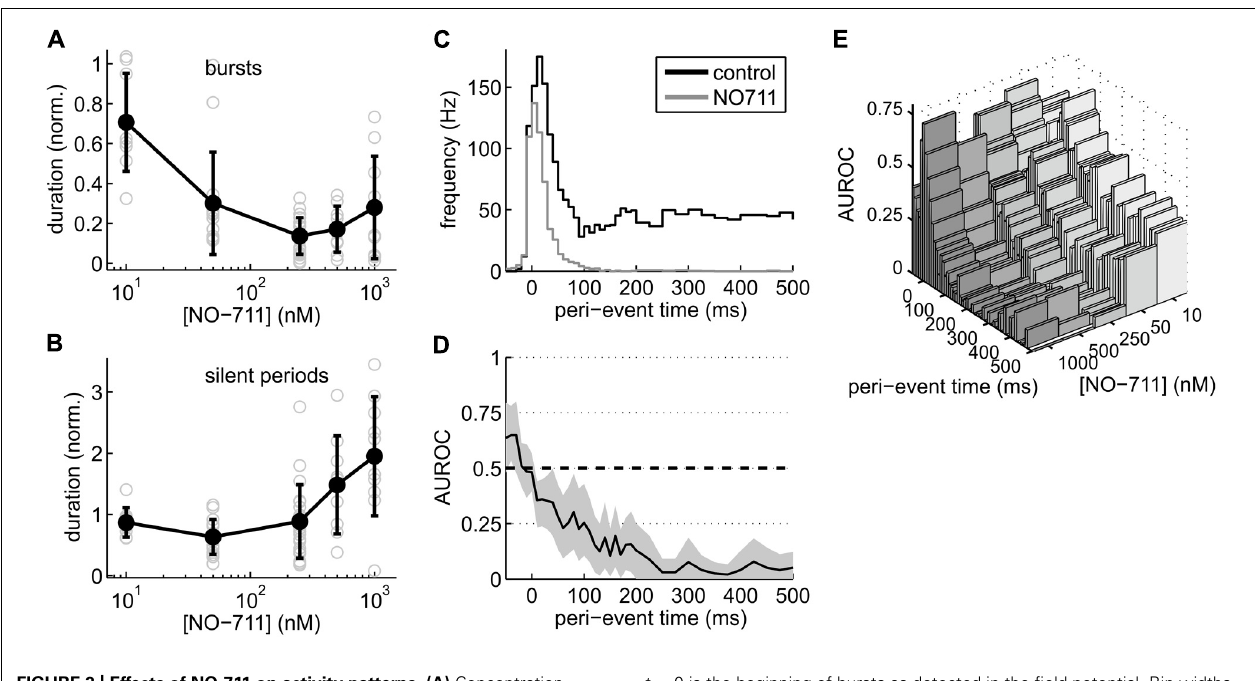
FIGURE 3 | Effects of NO-711 on activity patterns. (A) Concentration– response plot of burst duration normalized to control (means ± sd; gray open symbols are data from individual experiments). (B) Concentration–response plot of silent periods [same conventions as in (A) ]. Note different scale of ordinate. (C) Peri-burst time histograms of multiunit firing activity during control and 250 nM NO-711 ( n = 16, paired data, median of all experiments).